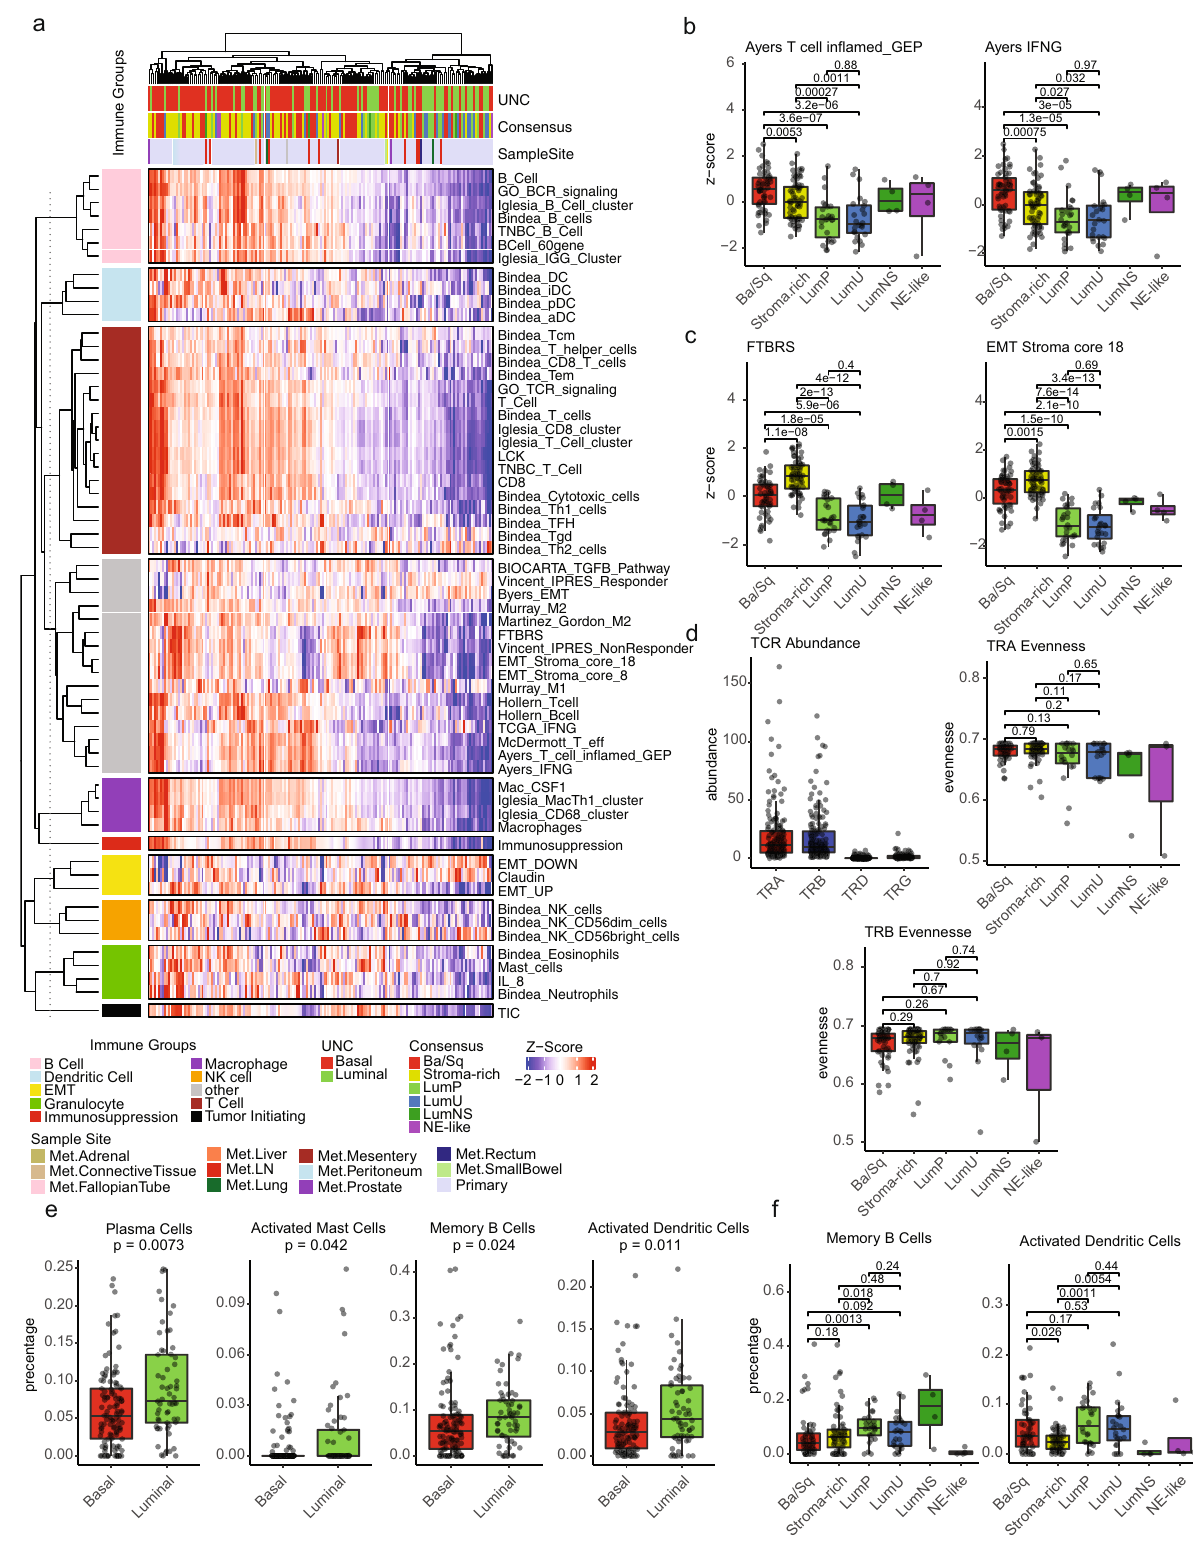
Fig. 4 | Ba/Sq tumors are T cell in fl amed but luminal tumors are enriched in memory B cells and plasma cells. a Tumor samples ( n =176 samples) were clus- tered by samples and Immune Gene Signature (IGS) z-scores. IGS were clustered within their respective immune group (right of dashed line). Boxplots for sig- natures related to ICI response and b T-cells or c stroma/EMT were plotted by z - score and consensus subtype ( n =176 samples). d TCR family abundance and